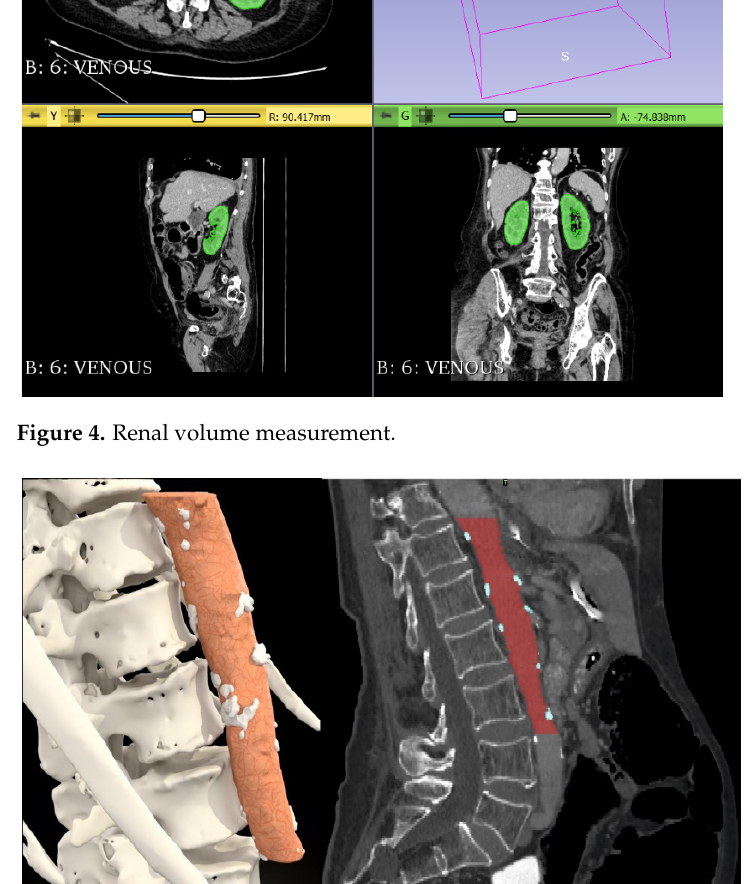
Table 1. Baseline characteristics of study groups.